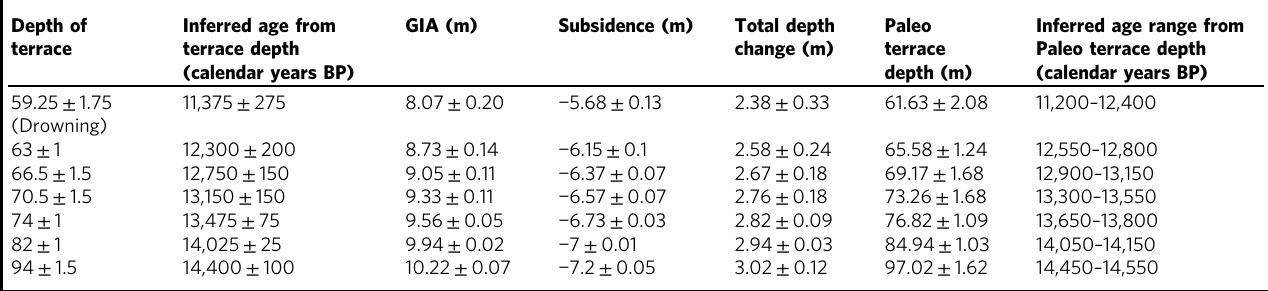
Table 1 Estimated Paleo terrace depths and their age range (see details in the text and methodologies) Depth of